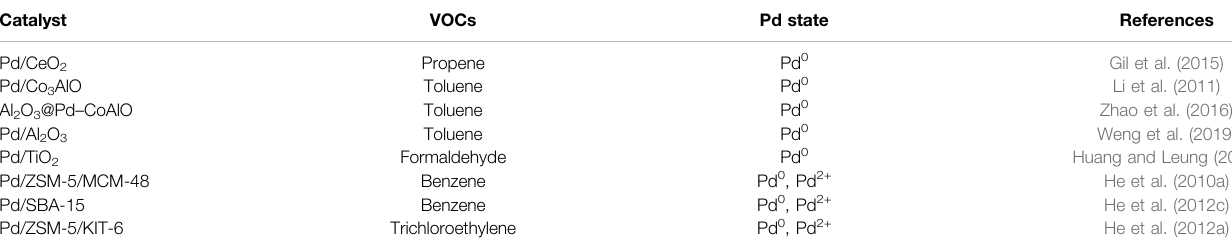
TABLE 1 | Catalytic oxidation of volatile organic compounds (VOCs) with different Pd states. Catalyst